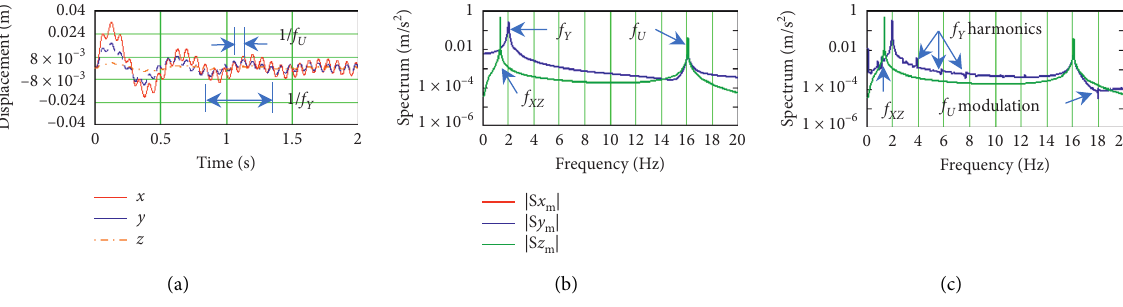
Figure 7: Transient vibration (a); vibration spectrums for new (b); and cracked (c) spring.